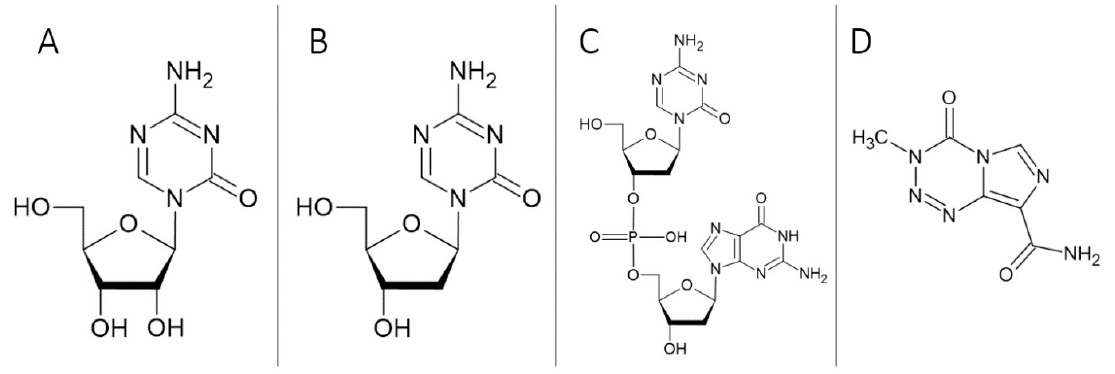
Figure 2. ( A ) Azacitidine, ( B ) decitabine, ( C ) guadecitabine, ( D ) temozolomide.